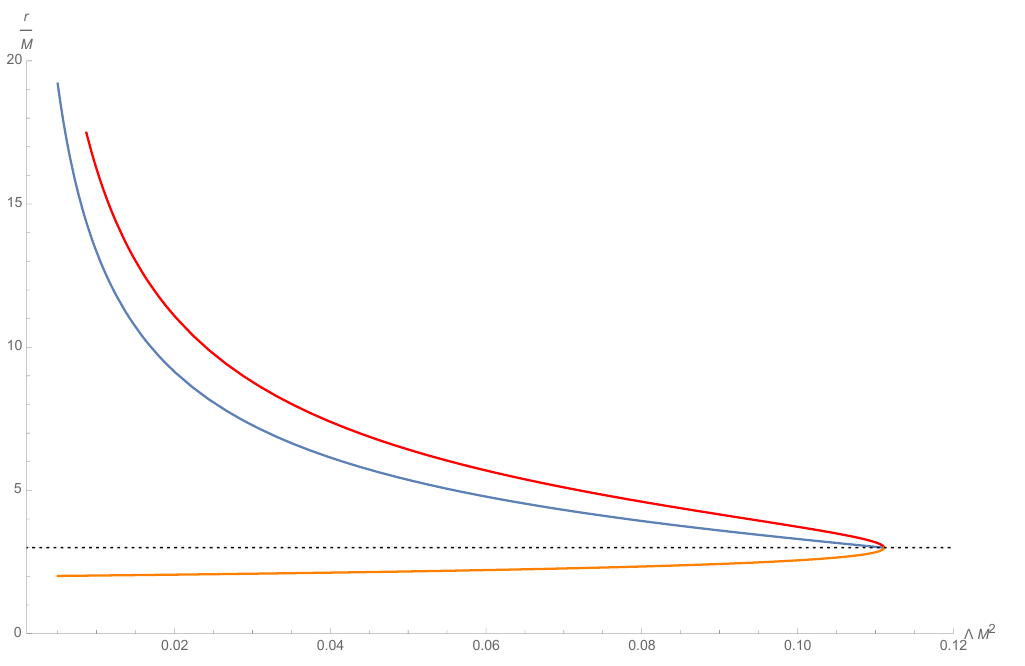
Figure 1. In this figure, the wormhole throat a 0 is represented by the solid blue line which falls between the event horizon r h (orange) and the cosmological horizon r c (red) for all Λ M 2 < 1/9. We note that Λ M 2 = 1/9 is the extremal limit where both horizons degenerate into one, and all r c , r h , a 0 → 3 M . This point is excluded from our wormhole construction domain. In addition, we note that the Λ = 0 limit is